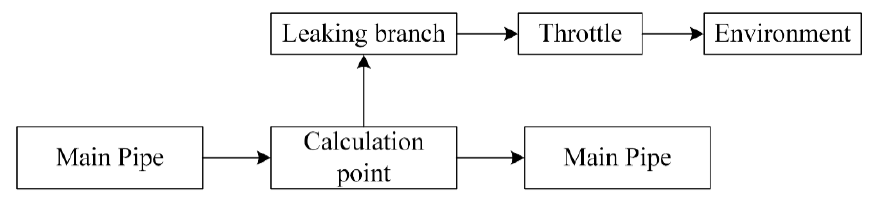
Figure 2. Pipeline leakage model in IES.